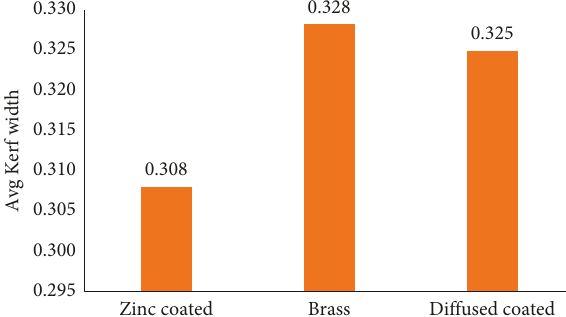
Figure 6: Average kerf width for zinc coated, brass, and diffused wire electrodes.